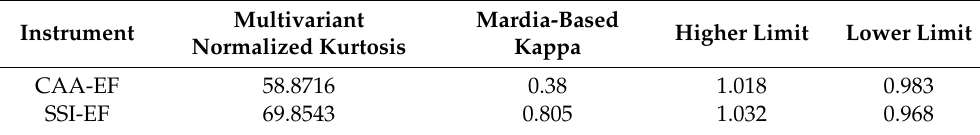
Table 1. Values of multivariate normality test.